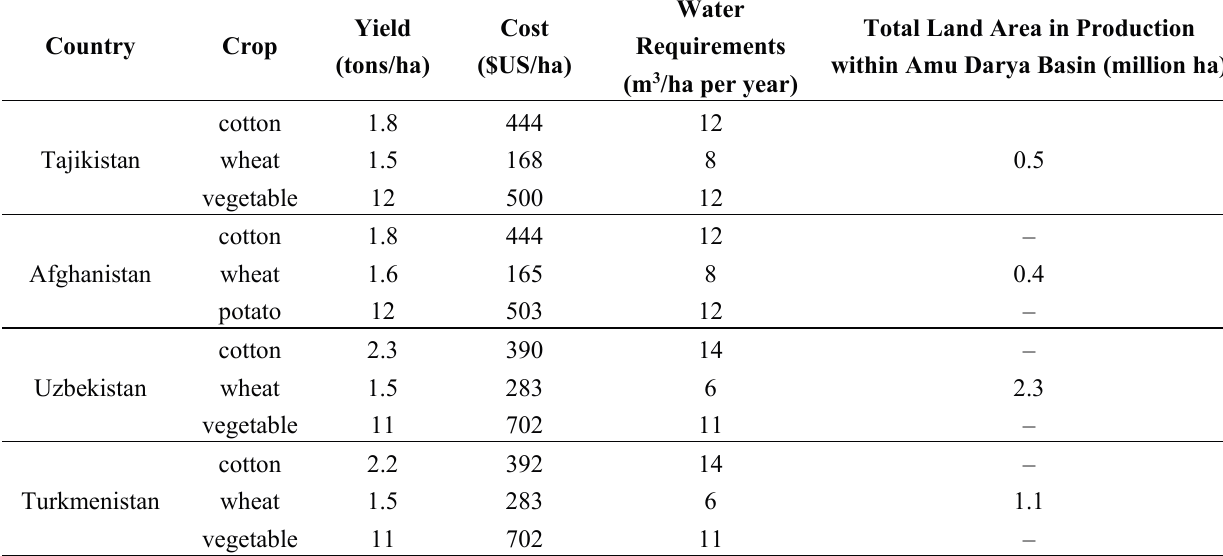
Table 1. Agricultural data by country and crop. The total land area in production indicates the sum for all three crops. Source: